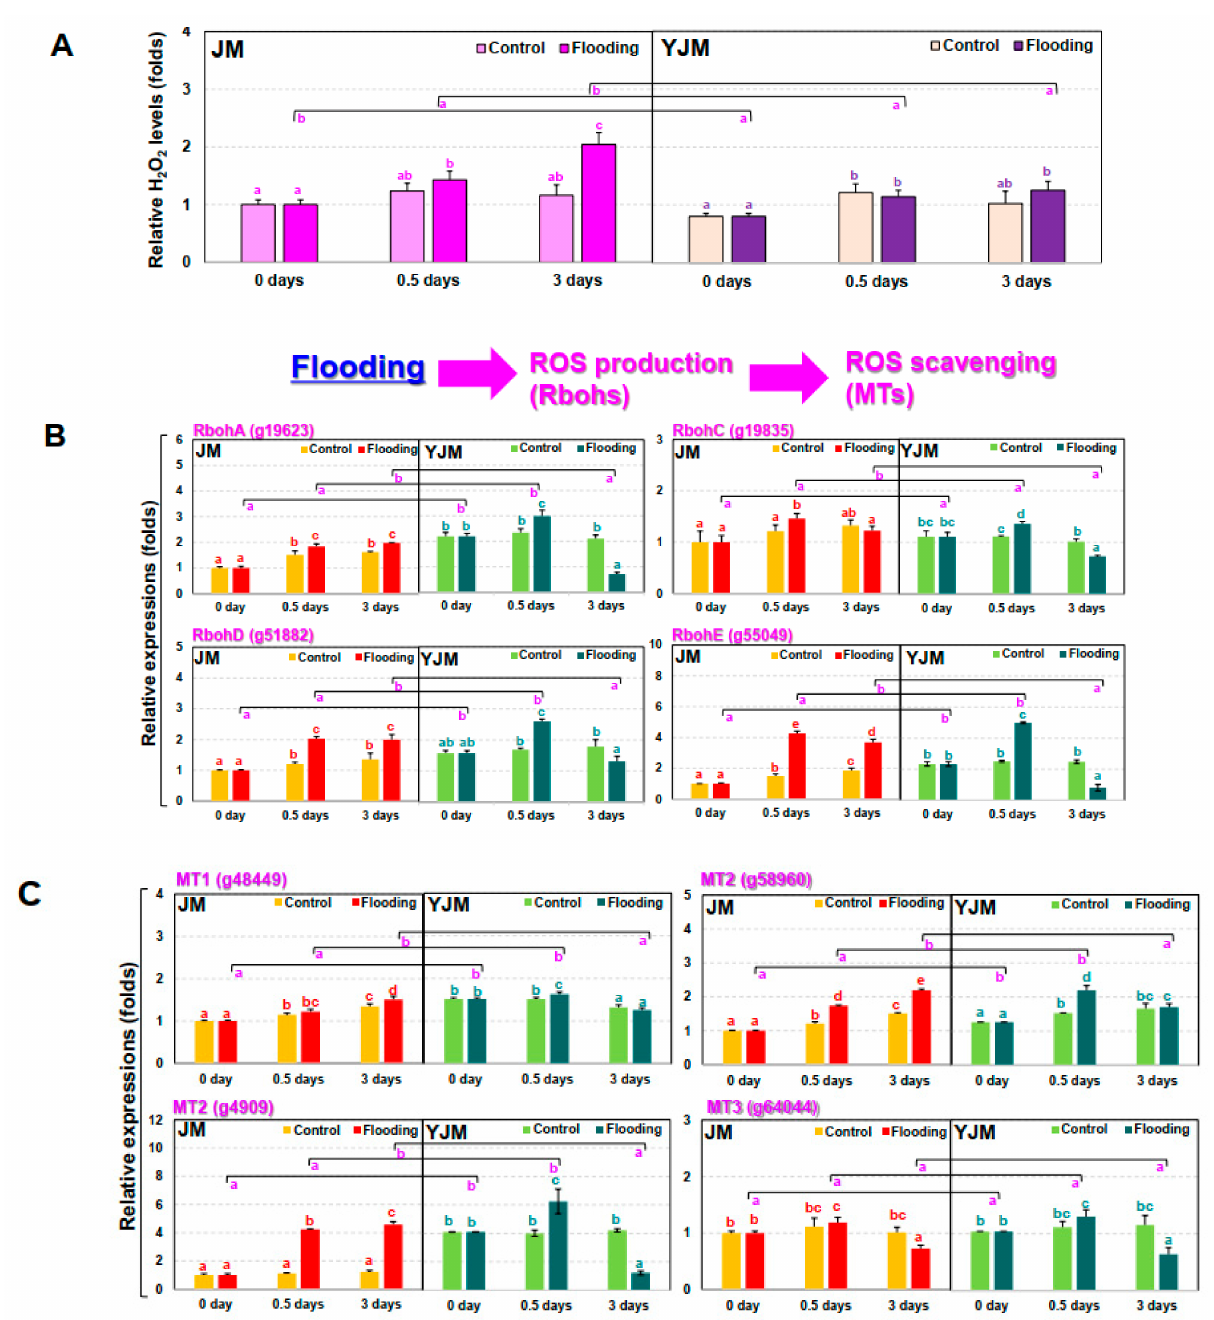
Figure 2. Expression of genes related to hydrogen peroxide (H 2 O 2 ) and ROS pathways in sweet potato cultivars treated with flooding stress for 3 d. ( A ) Relative levels of H 2 O 2 in each cultivar after 0, 0.5, or 3 d of flooding treatment. ( B ) Expression of RBOH genes in each cultivar after 0, 0.5, or 3 d of flooding treatment. ( C ) Expression of MT genes in each cultivar after 0, 0.5, or 3 d of flooding treatment. Different letters represent significant differences between control and flooding treatment, and between flooding-treated JM and YJM, determined using two-way ANOVA with the LSD post hoc test; p <